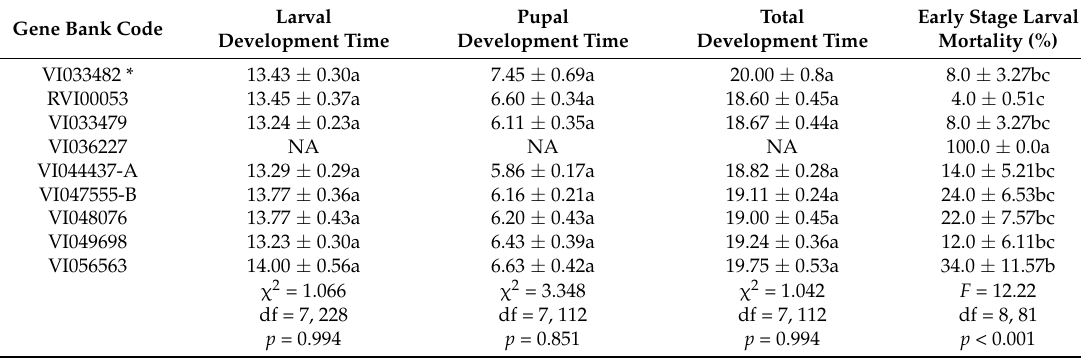
Table 4. Larval, pupal and total developmental times (mean ± SE) (days) of S. recurvalis on selected amaranth accessions and early stage (36 h) larval mortality on each